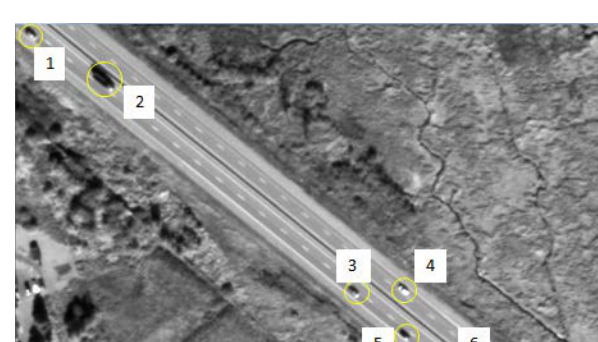
Figure 7: Workflow for vehicle’s speed computation